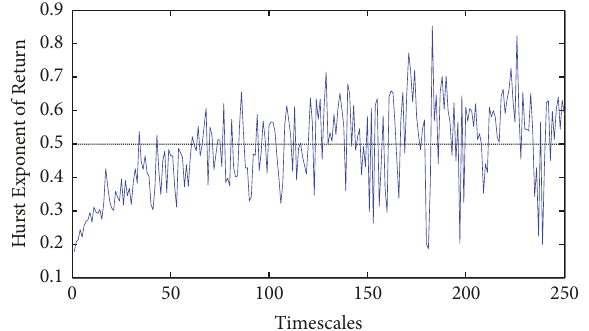
Figure 7: Hurst exponent of the market return series.